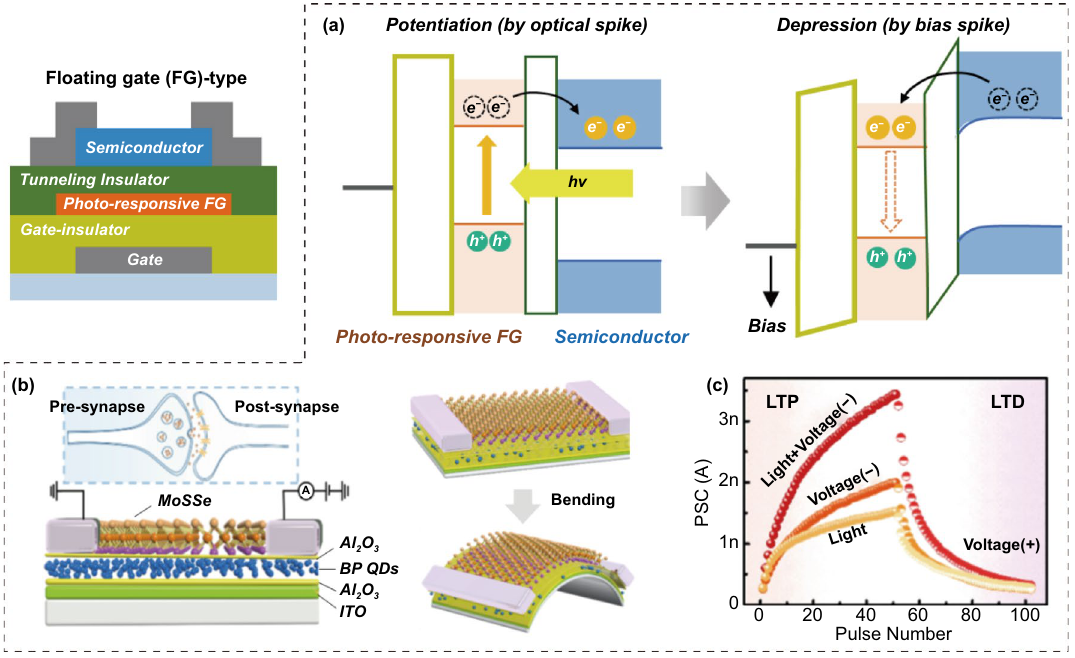
Fig. 9 FG transistor‑type OS; a operational mechanism, b black phosphorus (BP) quantum dots (QDs)‑FG transistor‑type OS, and c optical potentiation and electrical depression characteristics. b , c Reproduced with permission from Ref. [72]. Copyright @ 2021,